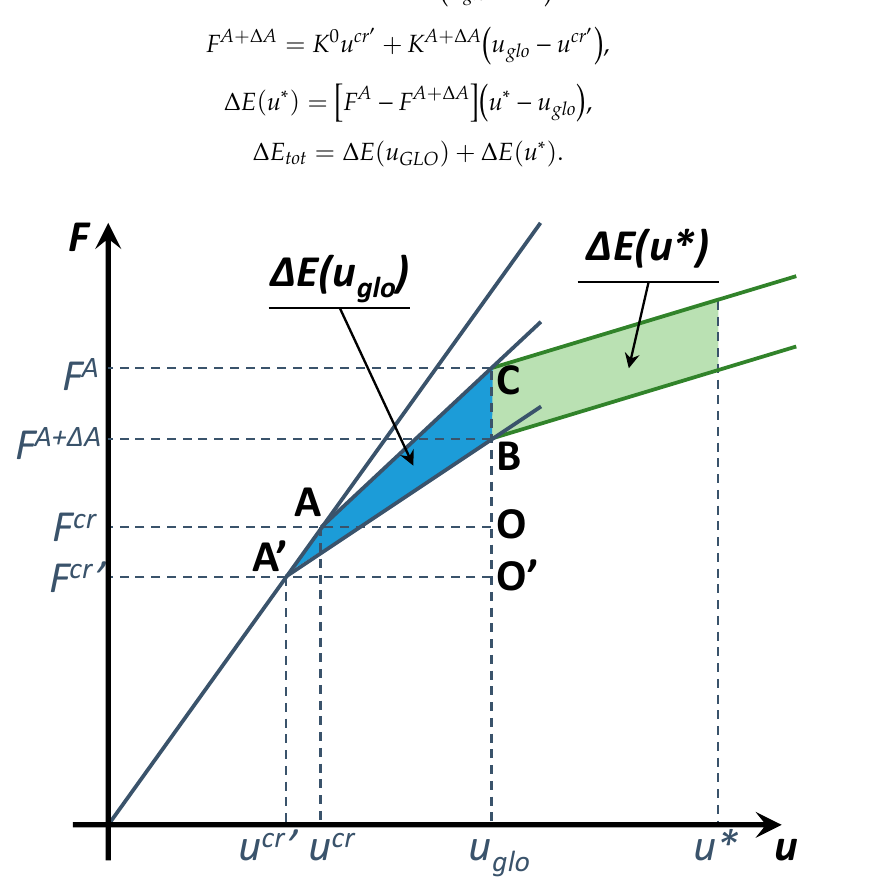
Figure 4. Schematic rapresentation of energy relase rate evaluation considering mode I and mode II interaction: u* > u glo .